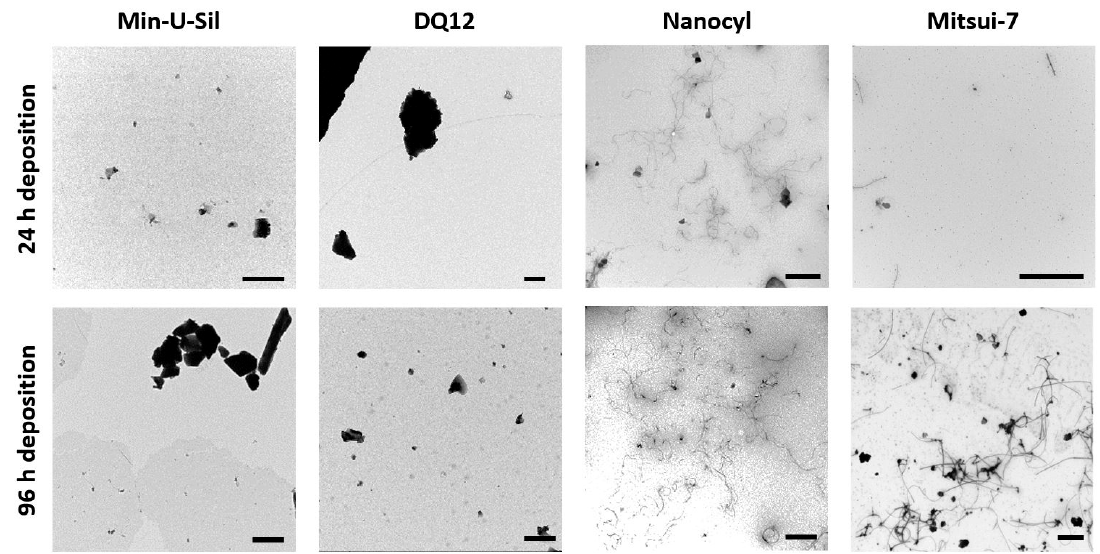
Figure 2. TEM micrographs represent the amounts of 24 h (1 × exposure) and 96 h (5 × exposures) deposition of Min-U-Sil, DQ12, Nanocyl, and Mitsui-7 particles. The scale bar is 1 µ m for Min-U-Sil, DQ12, and Nanocyl samples, and 5 µ m for Mitsui-7 CNTs.